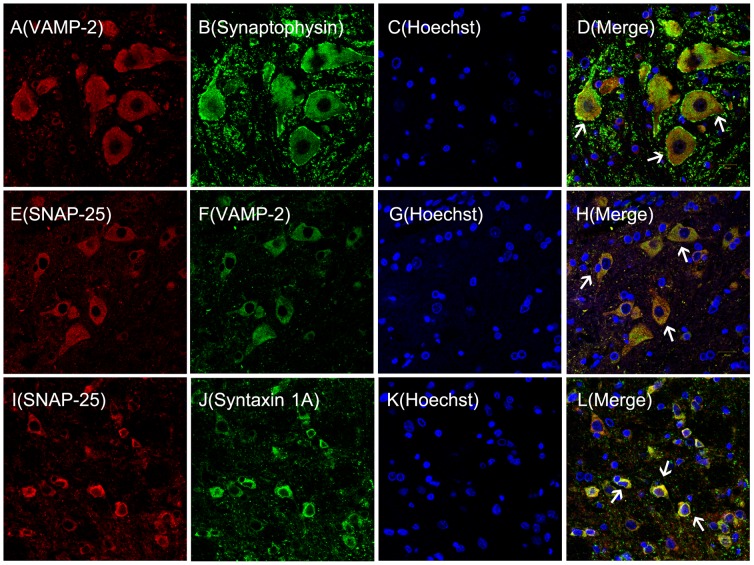
Synaptophysin colocalizes with VAMP-2, SNAP-25, and syntaxin-1A in spinal cord neurons.Double-immunofluorescence staining in the neurons of the ipsilateral spinal cord. L4 and L5 sections taken from naïve rats stained for VAMP2 (red), synaptophysin (green), Hochest,(blue), SNAP-25, and VAMP2 (red). VAMP-2 colocalizes with synaptophysin (D, white arrow head) (A–D). SANP-25 colocalizes with VAMP-2 (H, white arrow head) (E–H). SNAP-25 colocalizes with syntaxin-1A (L, white arrow head) (I–L). (n = 3/group, magnification X40, Bar = 20 µm).